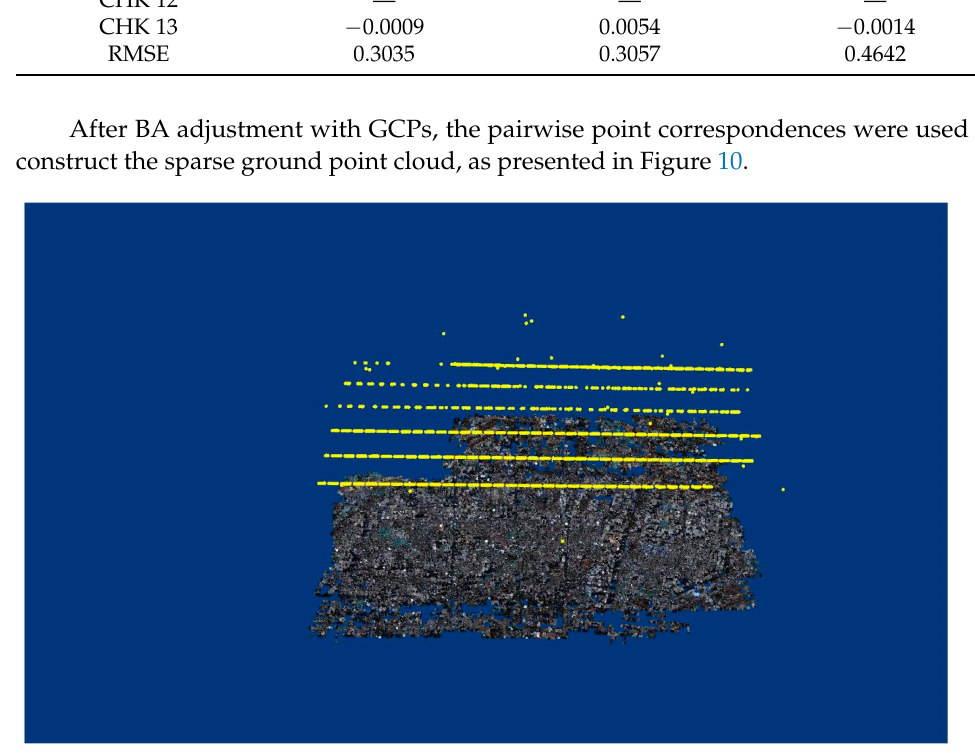
Figure 10. Sparse Point Cloud After the Second